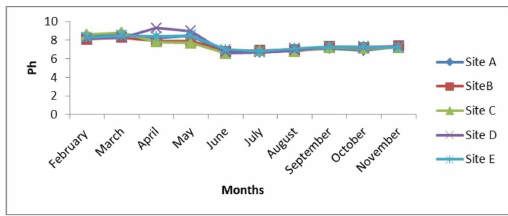
Figure 3. Monthly mean variations in pH of Nasarawa